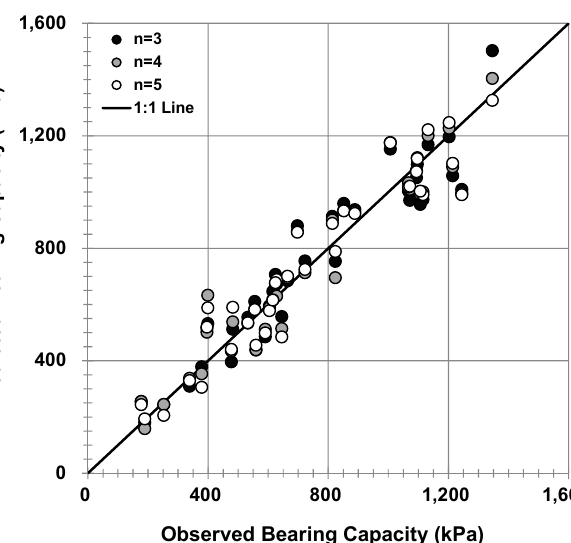
Figure 6. Comparison of predicted and observed ultimate bearing capacity by cross-validation.